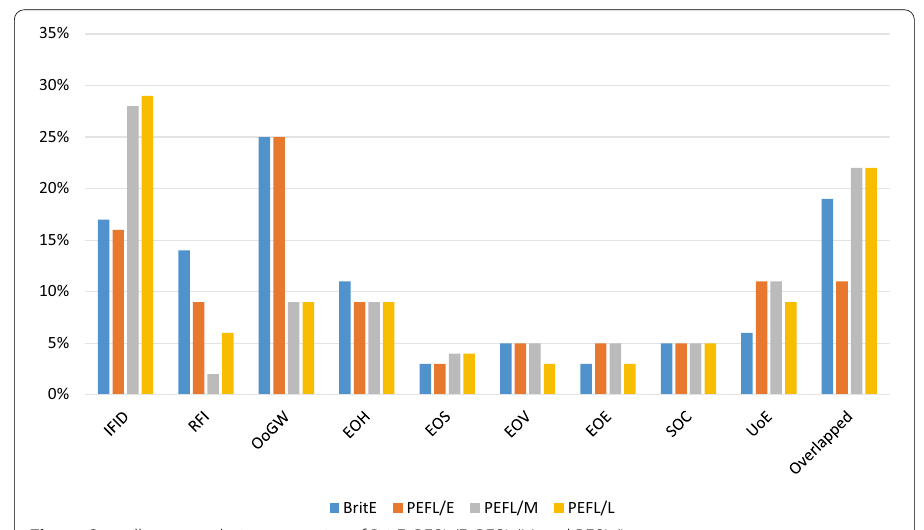
Fig. 1 Overall congratulation strategies of BritE, PESL/E, PESL/M and PESL/L